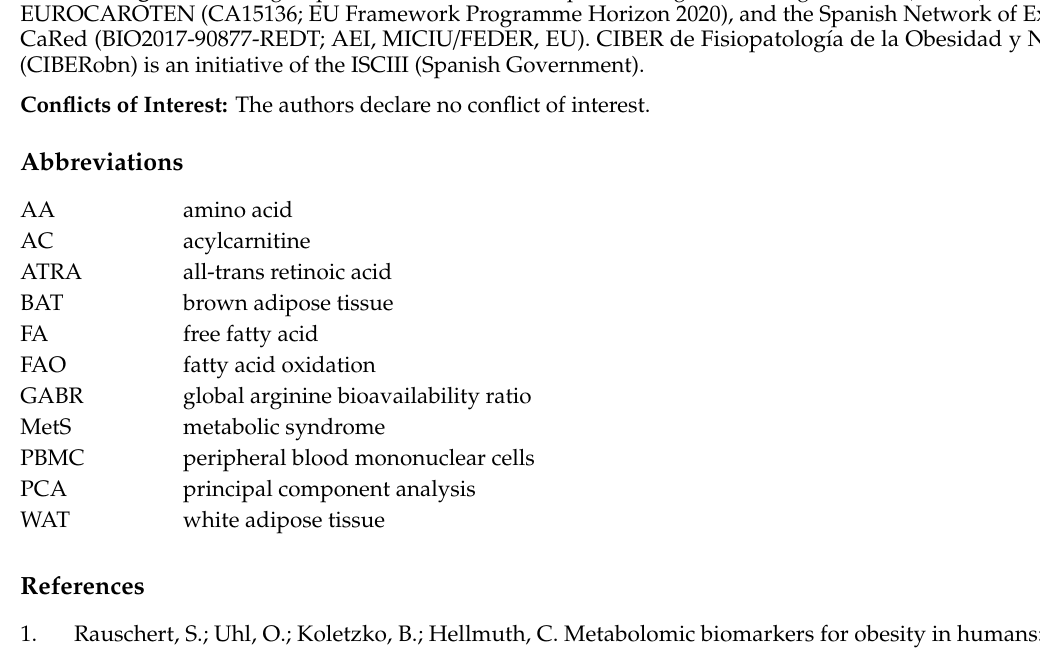
Supplementary Figure S1: Body weight evolution, food intake, and energy e ffi ciency during vehicle or ATRA treatment, and fat depots weights and adiposity and liver index at sacrifice. Supplementary Table S1: Total variance and principal components loadings for the first five principal components distinguishing control and ATRA-treated mice in PCA analysis. Supplementary Table S2: Correlations between plasma metabolites better discriminating between control and ATRA-treated mice according to PCA and selected variables related to thermogenic capacity in adipose